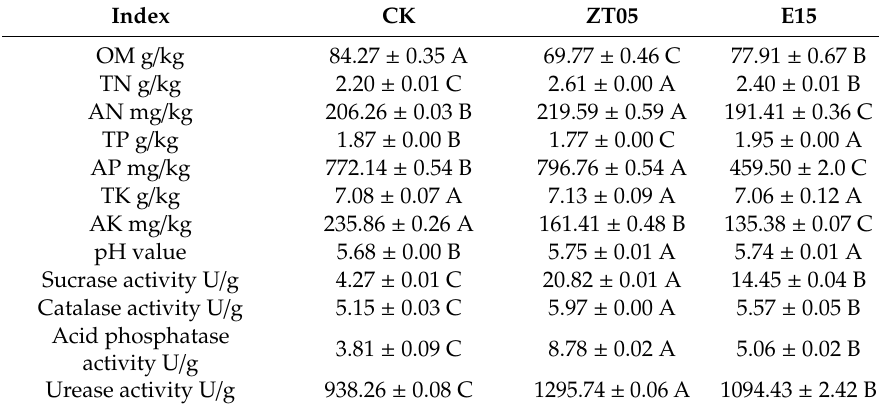
Table 2. E ff ects of Trichoderma inoculation on soil nutrients and soil enzyme activities of CK, ZT05, E15. CK: inoculation with PD blank culture medium. ZT05: single inoculation with T. virens ZT05. E15: single inoculation with T. harzianum E15. Di ff erent letters in the columns indicate significant di ff erences ( p < 0.05), according to Duncan’s new multiple range